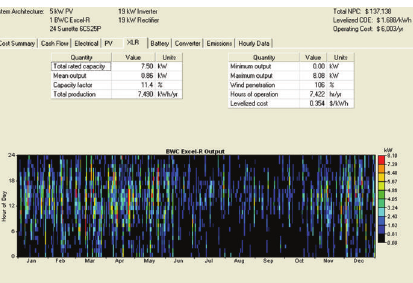
Figure 13: Wind turbine (BWC Excel-R) output summary.